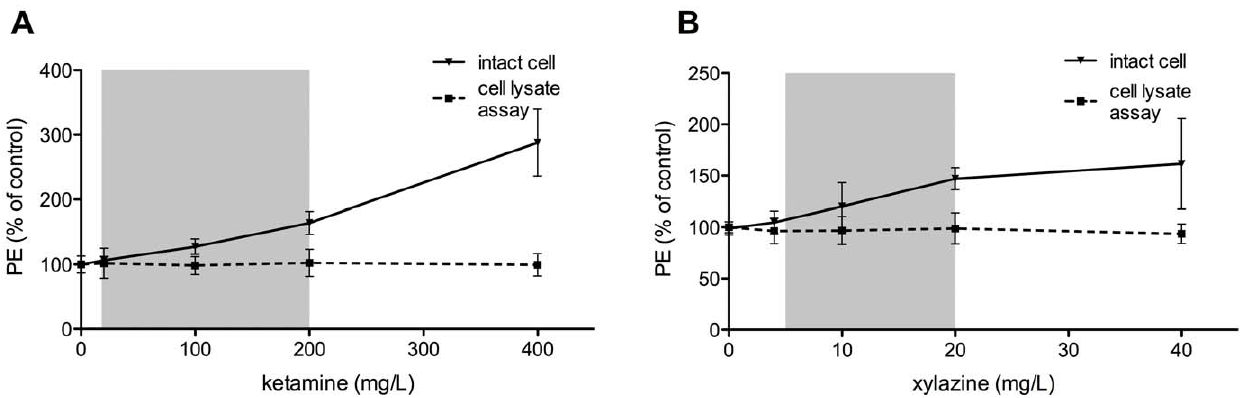
Figure 2. Effect of ketamine and xylazine on BLI signal of intact cells and cell lysates. The effect on photon emission (PE) of the anesthetics ketamine ( A ) and xylazine ( B ) are shown using intact cells (full line) and cell lysates (dotted line). All data are represented as mean % of control (absence of anesthetic) 6 SD. Grey intervals in the curves indicate the concentrations used in vivo , as reported in literature for mice.